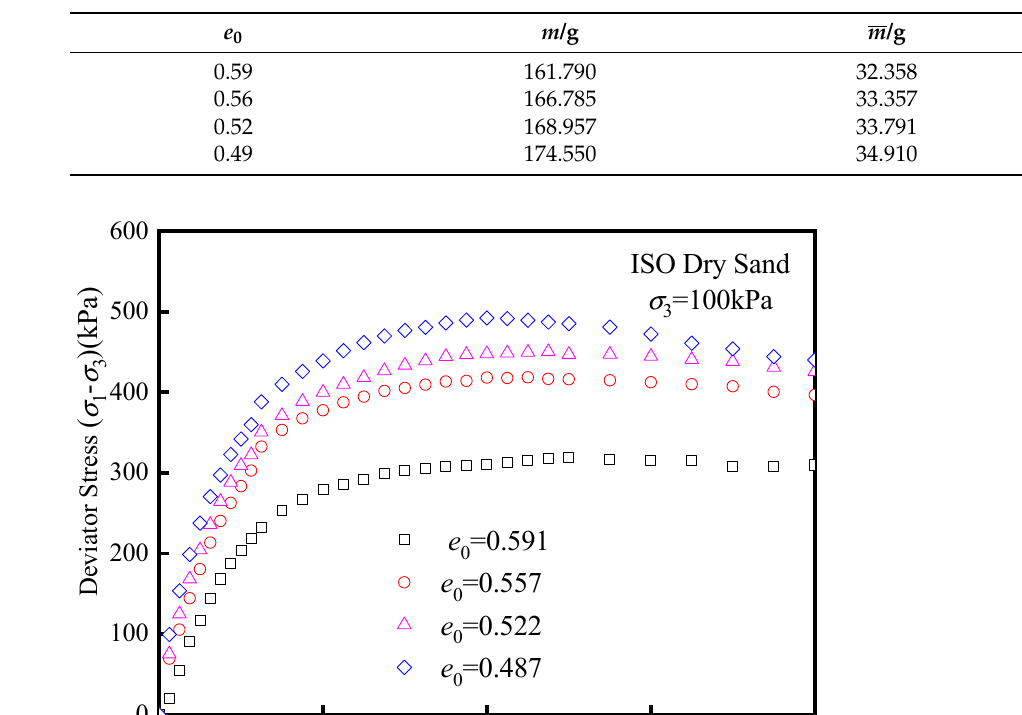
Table 2. Experimental cases for the ISO sand.